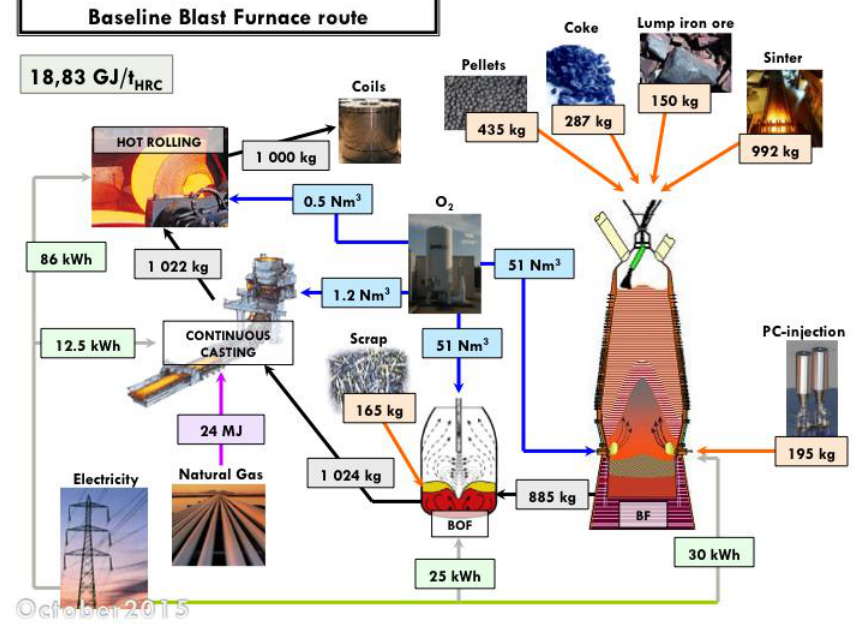
Figure 6. Mass and energy balance in an integrated steel mill (baseline blast furnace route, ULCOS simulation). Energy per ton of hot rolled coil (HRC).